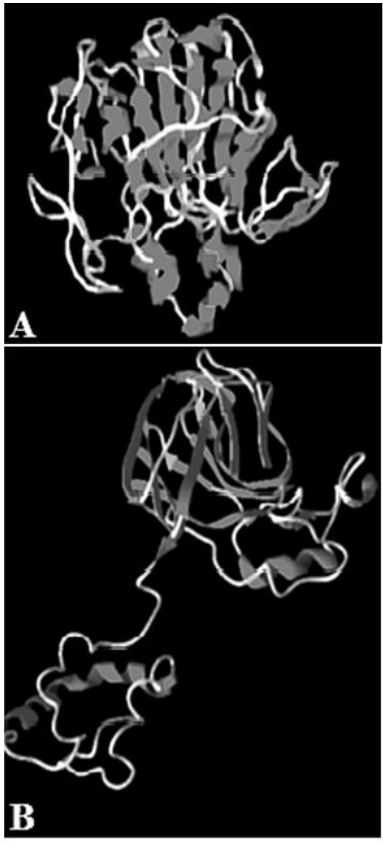
Fig. 3. Prediction of the tertiary structure of fused protein: A) I-TASSER web server; B) SynLinker web server.